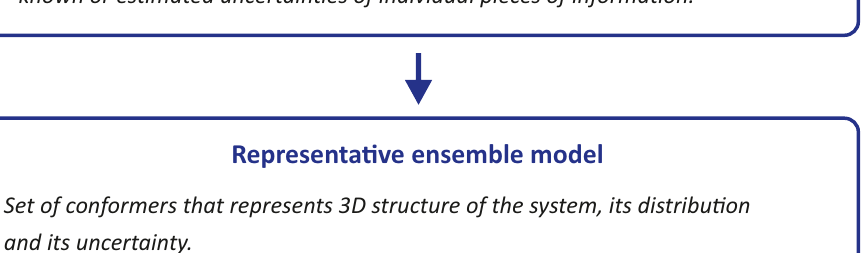
Figure 5. Integration of experimental information and information from knowledge bases into a hybrid ensemble model. The lists of information types for specifying ensembles are examples rather than being exhaustive. The balancing of potentially inconsistent information in the integration step is complicated by partially unknown uncertainty of pieces of information. Construction of a representative ensemble model is complicated by the requirement of separation of uncertainty from natural distribution of 3D